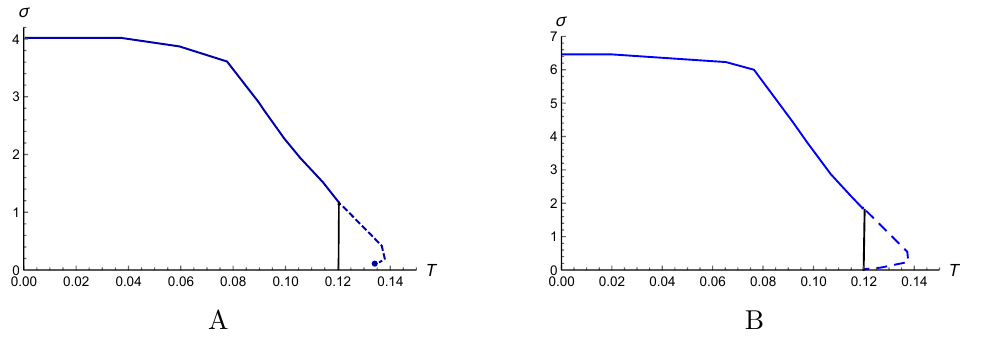
Figure 17 . String tension as function of temperature for z 0 = 10 exp( − z h / 4) + 0 . 1 , µ = 0 . 2 , ν = 4 . 5 , longitudinal (A) and transversal (B); a = 4 . 046 , b = 0 . 01613 , c = 0 . 227 . Solid lines — the realized values of string tension; black solid lines (A,B) — BH-BH phase transition; dashed blue lines — string tension for temperature higher than the temperature of BH-BH phase transition, T > T BH − BH